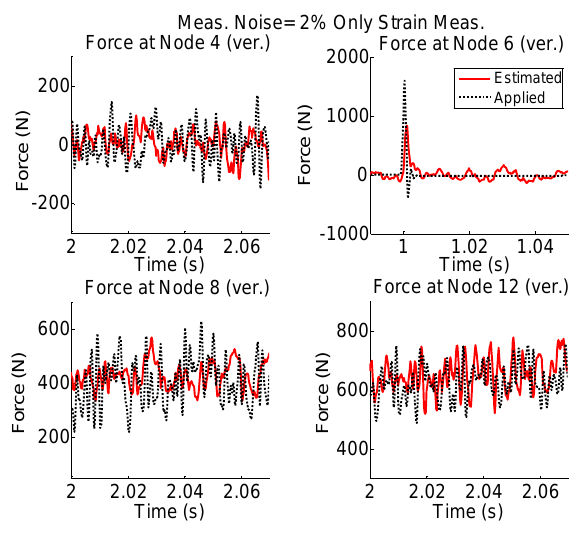
Figure 15. The results shown in Figure 14 are re-plotted for shorter time intervals to see the quality of